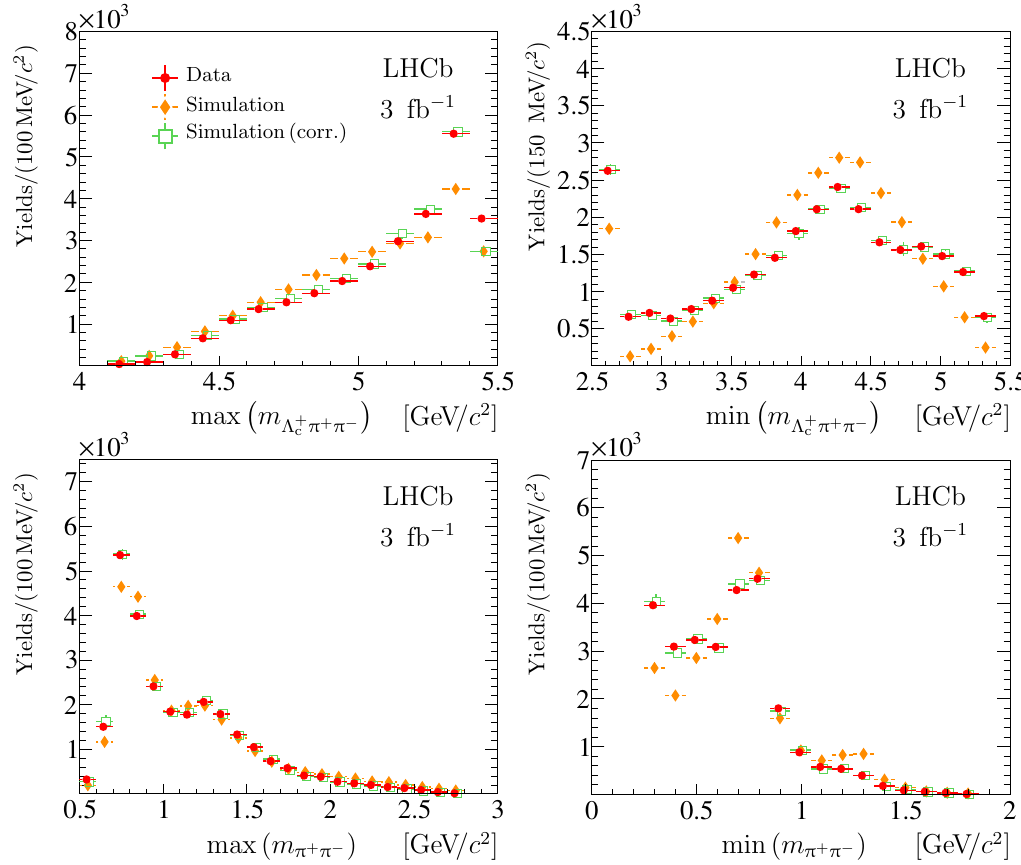
Figure 9 . Background-subtracted maximum and minimum Λ + mum π + π − mass spectra for the Λ 0 corrected (corr.) simulation are